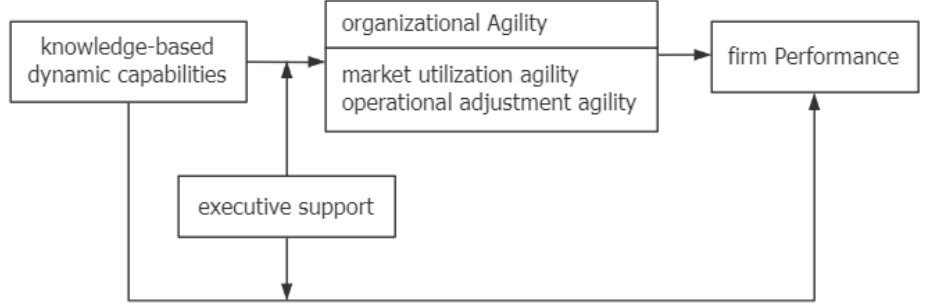
Figure 1. Research model.